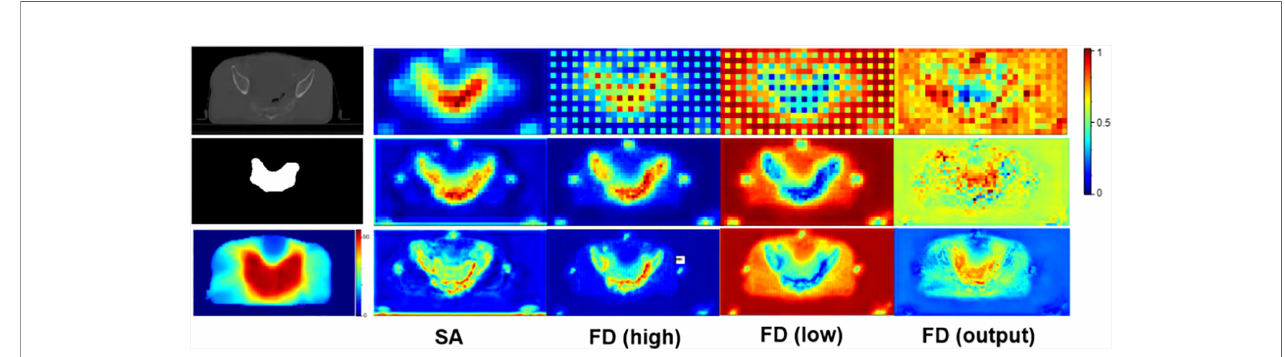
FIGURE 6 | The attention-weighted feature maps for SA and FD. The fi rst column from top to bottom shows the input CT image, tumor segmentation and dose distribution map separately. The second column visualizes the attention of SA module in tumor segmentation task. The following three columns illustrate the attention of FD module in dose prediction task. Speci fi cally, FD (high) and FD (low) denote high- and low-dose features, respectively, and the re fi ned output of FD is marked as FD (output). The redder the area is, the more attention the network pays. The top row refers to the results of the shallowest layer while the bottom row stands for the results of the